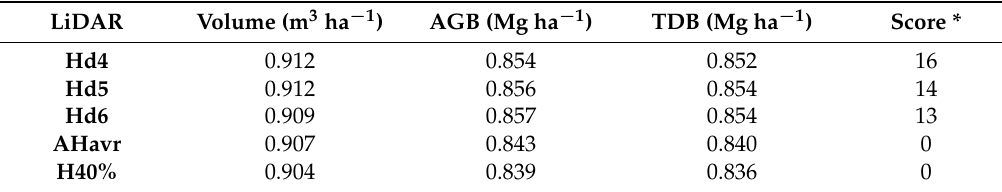
Table 5. Correlation coefficients between LiDAR and stand variables—Deciduous Broadleaved ( n = 55)